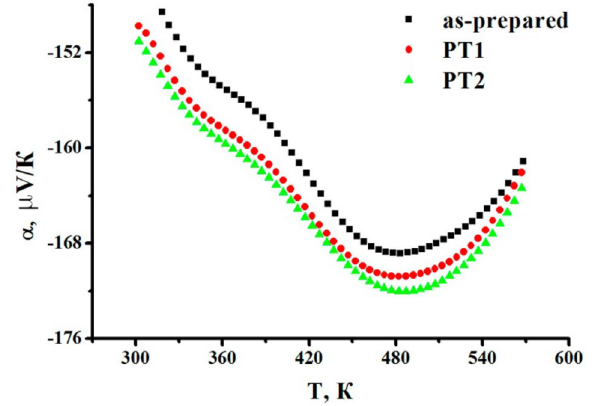
Fig. 8 The Seebeck coefficient as a function of temperature for as- prepared samples, after the single PT (PT1 curve) and double PT (PT2 curve) of the studied